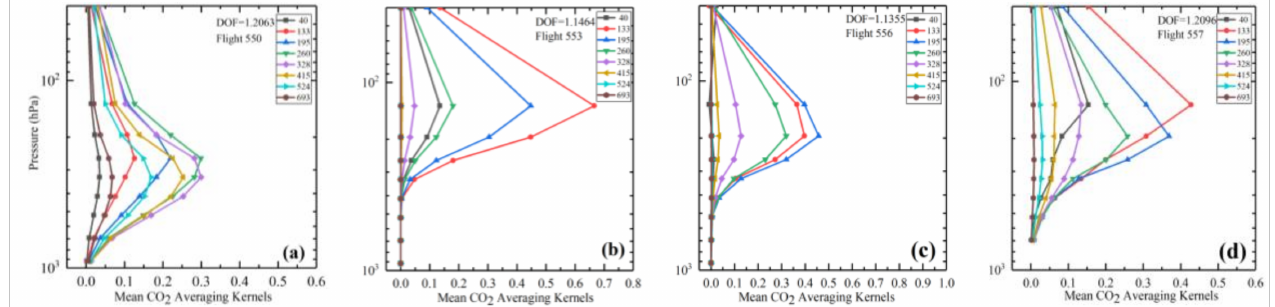
Figure 7. Mean averaging kernels of CO 2 retrievals ( a ) averaging kernels of flight No. 550, ( b ) averaging kernels of flight No. 553, ( c ) averaging kernels of flight No. 556, ( d ) averaging kernels of flight No. 557.